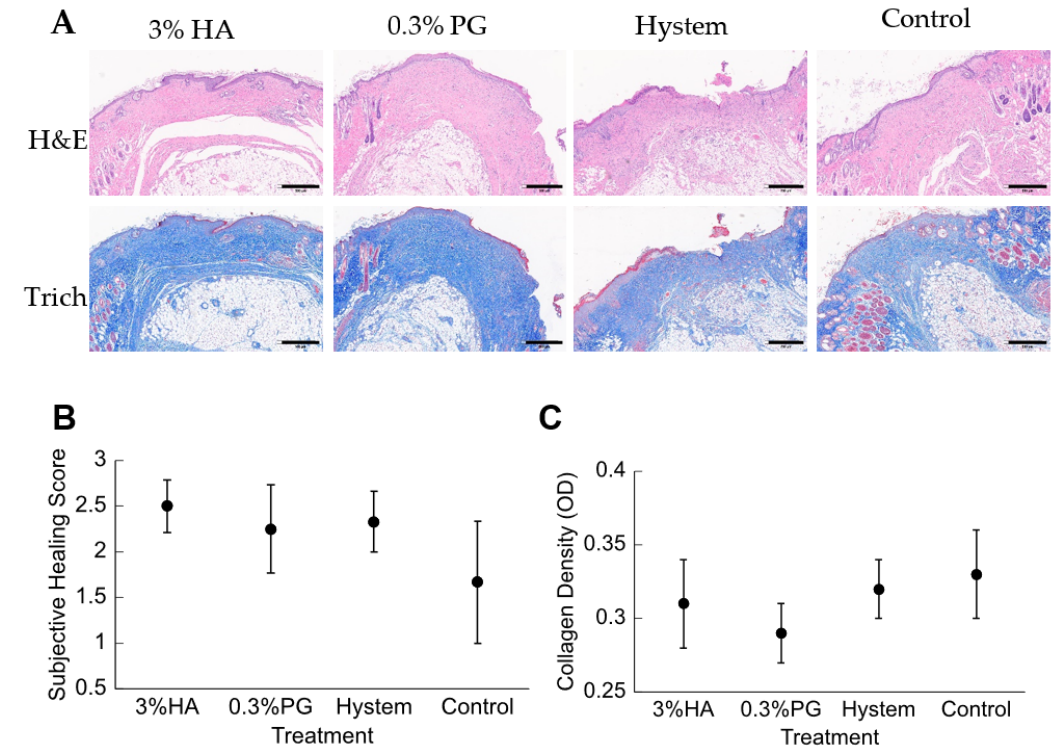
Figure 6. Histologic analysis of mouse cutaneous wound samples. ( A ). Hematoxylin and eosin (H&E) and Masson’s Trichrome (Trich)-stained samples from each treatment group. Scale bars were shown on the bottom right of every image. Scale bar for 3% HA and Control = 500 µm, scale bar for 0.3% PG = 600µm, scale bar for Hystem = 700 µm. ( B ). Re-epithelialization scores for each treatment group. Results are shown as mean ± SEM. ( C ). Collagen density from each treatment group expressed in optic density (OD). Results are shown as mean ± SEM.